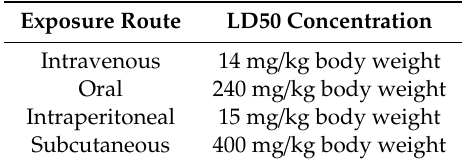
Table 7. Lethal dose (LD50) for benzalkonium chloride in